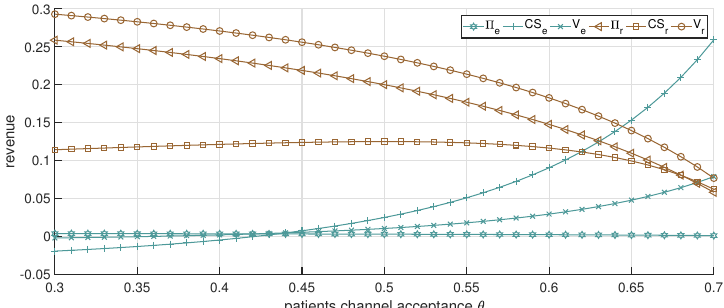
Figure 11. The impact of changes in θ on CS and V (the dual-channel strategy p 0 =